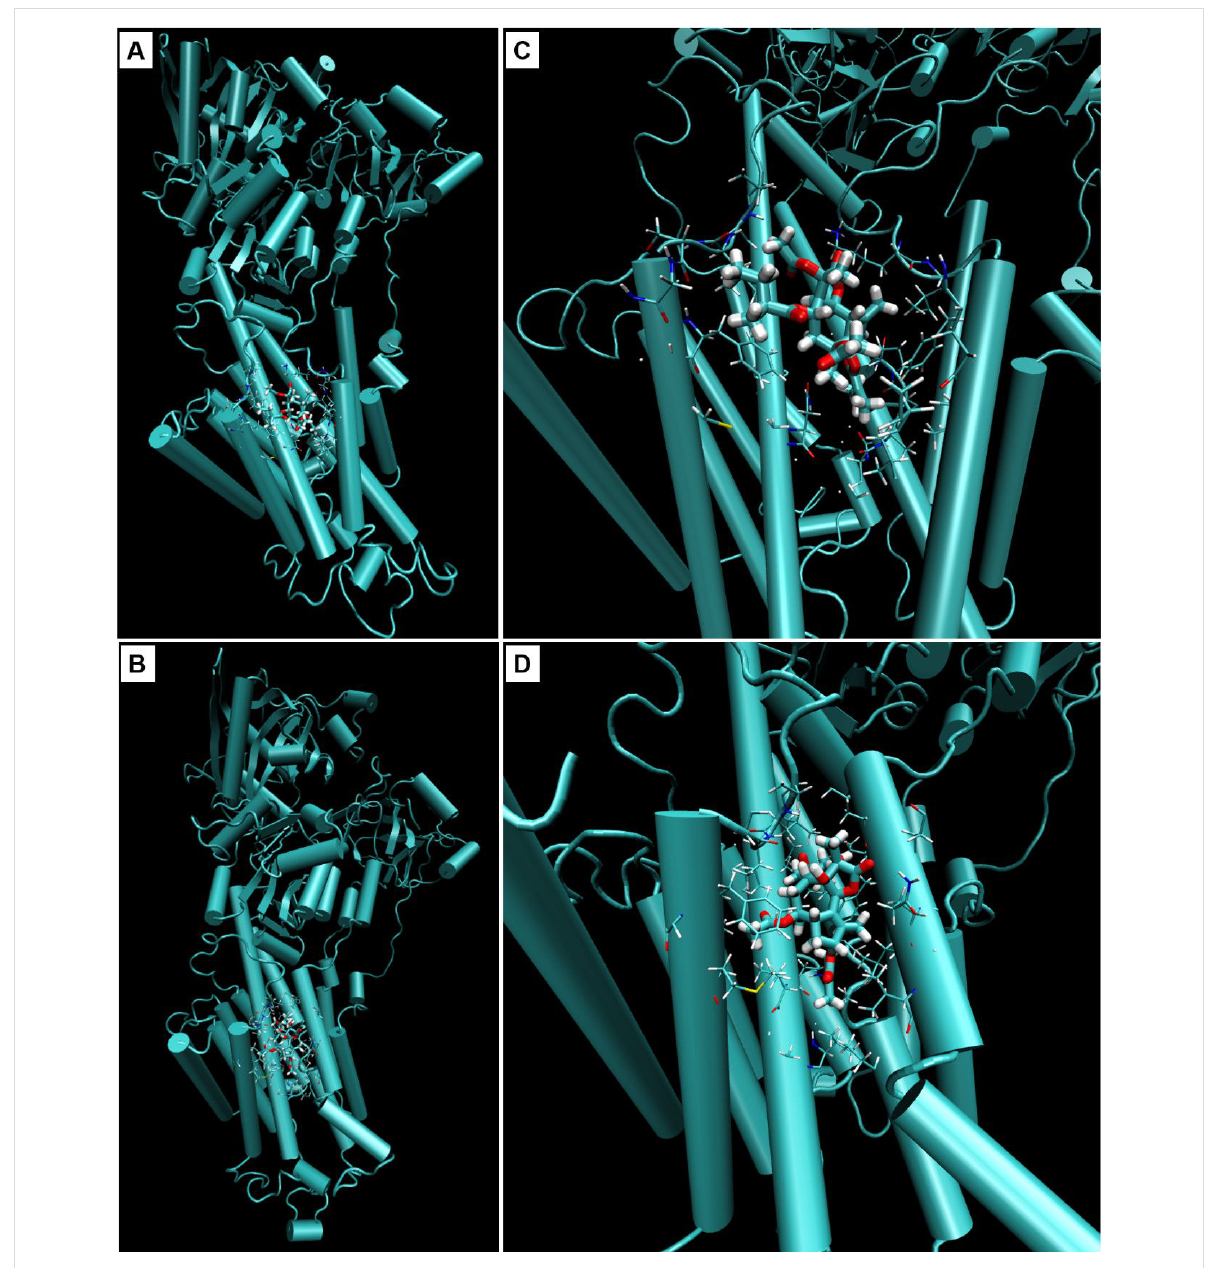
Figure 4: Cartoon representation of sarco/endoplasmic reticulum Ca 2+ ATPase binding pocket with A, C) archangelolide ( 1 ) or B, D) trilobolide ( 2 ) after molecular dynamic simulations. Depicted are also amino acid residues in a range of 5 Å from the respective ligand. The images were created using VMD software, version